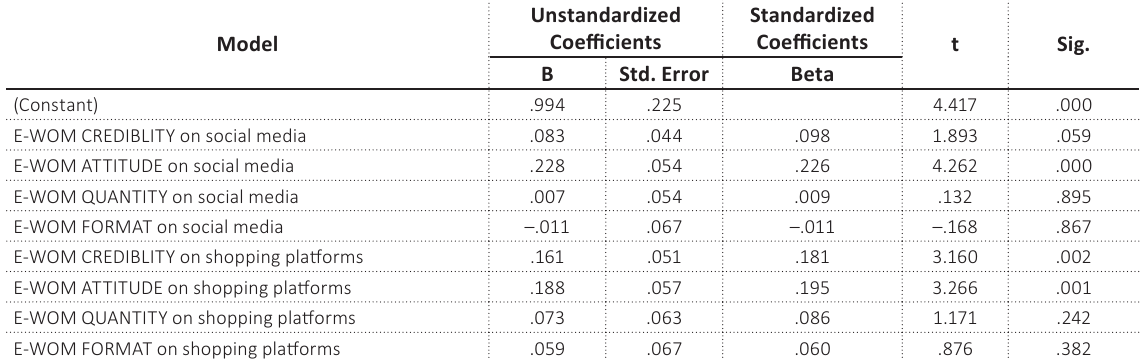
Table 5.3. Multiple regression analysis of dependent and independent